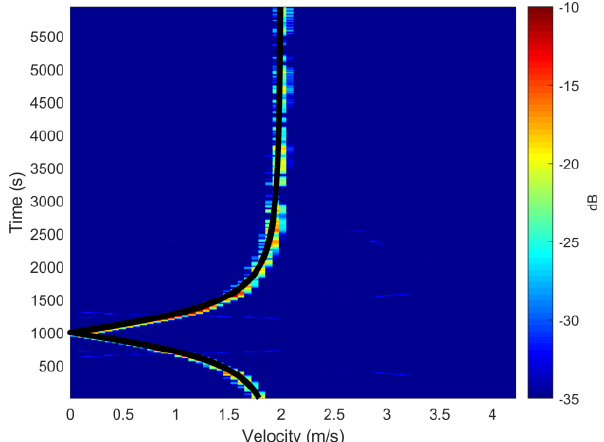
Figure 4. Comparison of radial velocity estimates with theoretical values (the black solid line in the figure) versus time.